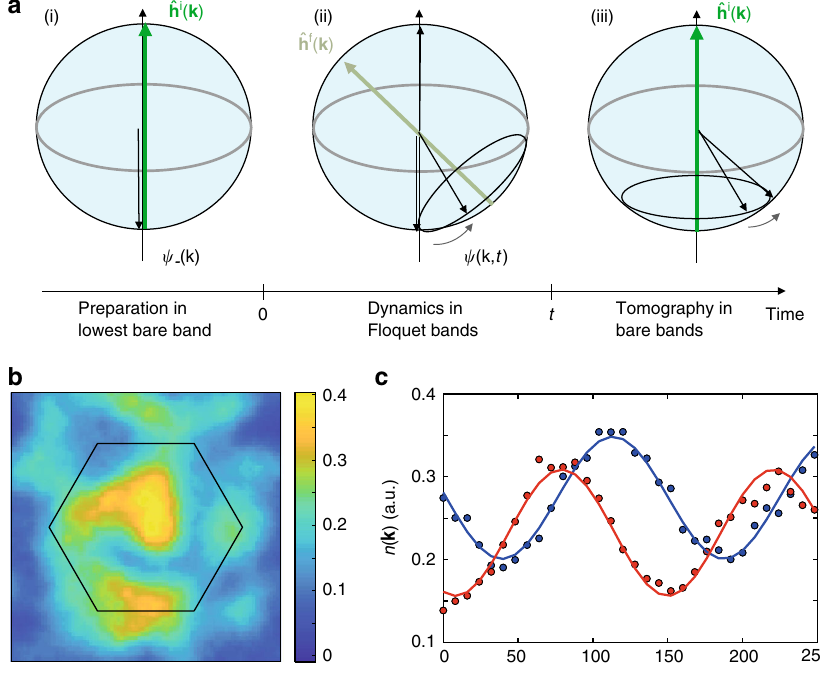
Fig. 4 Illustration of the time-resolved state tomography. a The states of the two-band model can be visualized on a Bloch sphere with the eigenstates of the two bare bands on the poles. (i) We initialize the state of the system in the lower bare band of b h i ð k Þ (south pole). (ii) We quench into the fi nal Floquet system b h f ð k Þ by suddenly switching on the lattice shaking. The state Bloch vectors (black arrow) evolve on the Bloch sphere according to the Floquet Hamiltonian. (iii) We measure the time-evolved state by projecting back onto the bare bands of b h i ð k Þ and following the dynamics. When the time-evolved state Bloch vector ψ ( k , t ) is at one of the poles, this leads to the absence of dynamics in the tomography and to a vortex in the azimuthal phase pro fi le. b Example image of the momentum density n ( k ) obtained by time-of- fl ight expansion for detuning δ = − 2 π ⋅ 372 Hz, evolution time t = 0.429 ms and tomography time t ′ = 104 μ s. The hexagon marks the fi rst Brillouin zone. c The interference of the A and B sublattices maps the precession onto an oscillation in the density, from which one obtains the phase ϕ ( k , t ) and the amplitude sin ( θ ( k , t )) (compare Eq. (7)). The plot shows the oscillation with the respective fi t for a selected pixel in the image in b , i.e. a single momentum state, and for the evolution time t = 0.429 ms (blue) and t = 0.624 ms (red) in the Floquet system. While the illustration assumes fl at bands for simplicity, where the initial state points to the south pole, the conclusions about the topology remain valid for the dispersive bands used in the